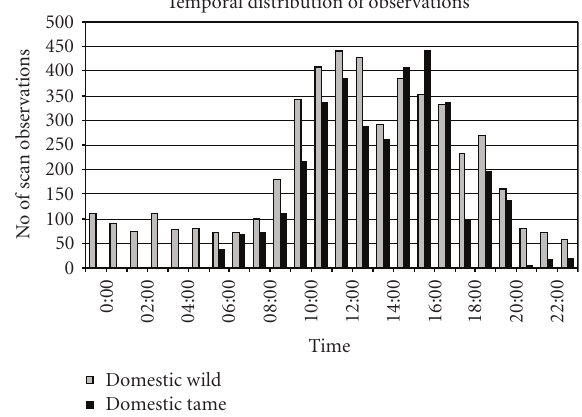
Figure 5: Number of scan observations from the two trials divided into